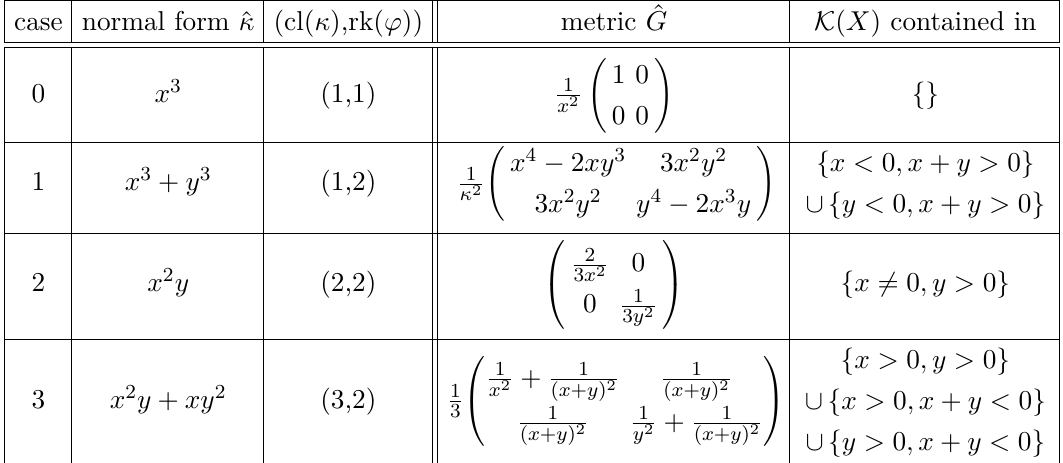
Table 3 . Classification of intersection forms for CYs X with h 1 , 1 ( X ) = 2 . The metric ˆ G has been computed from the prepotential ˆ κ , using eq. (3.1). The regions where ˆ κ > 0 and ˆ G is positive definite are given in the last column and are plotted in figure